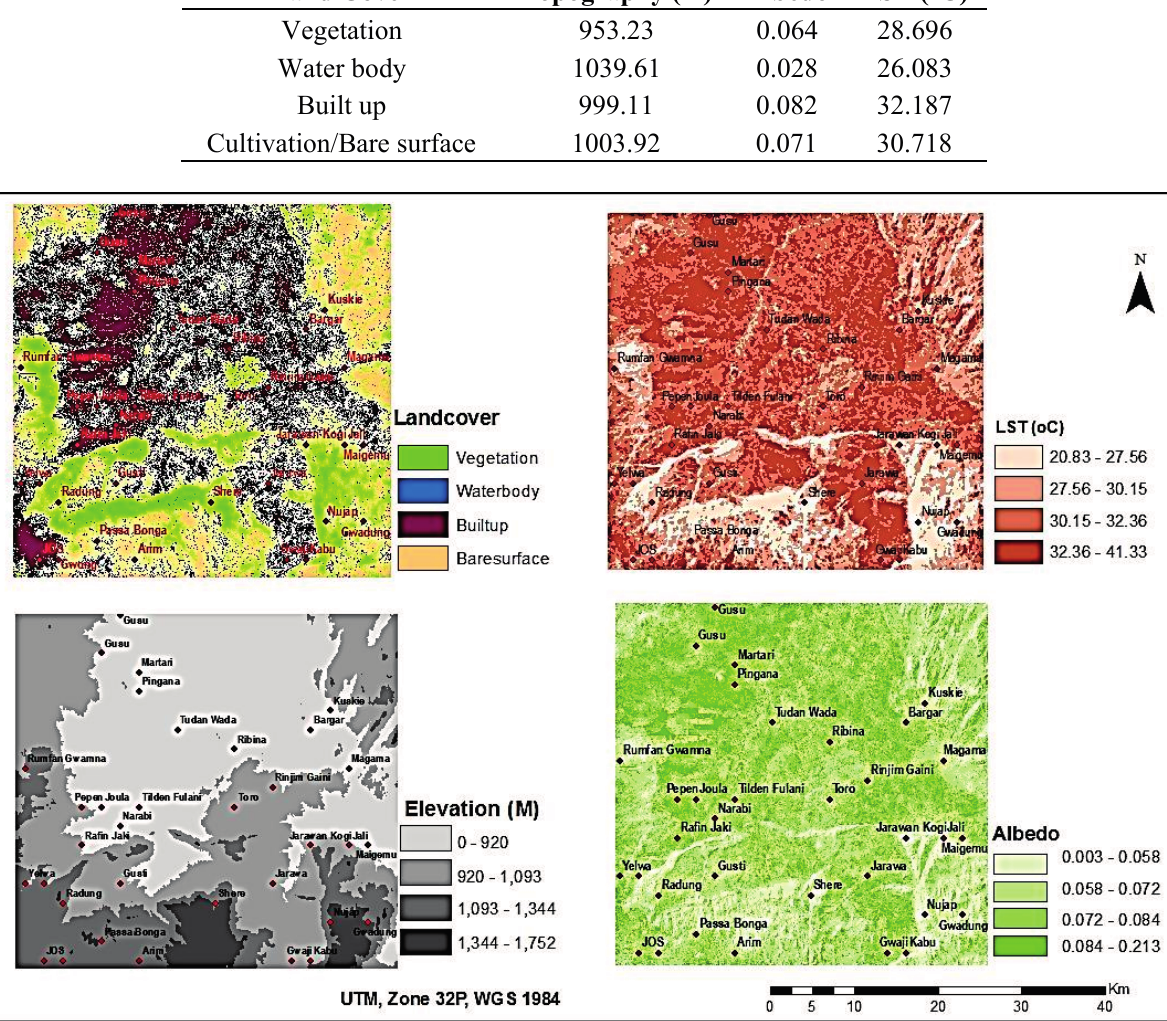
Table 7. Mean topography, mean albedo and mean LST across land cover types in Jos in1986. Land Cover Topography (m)